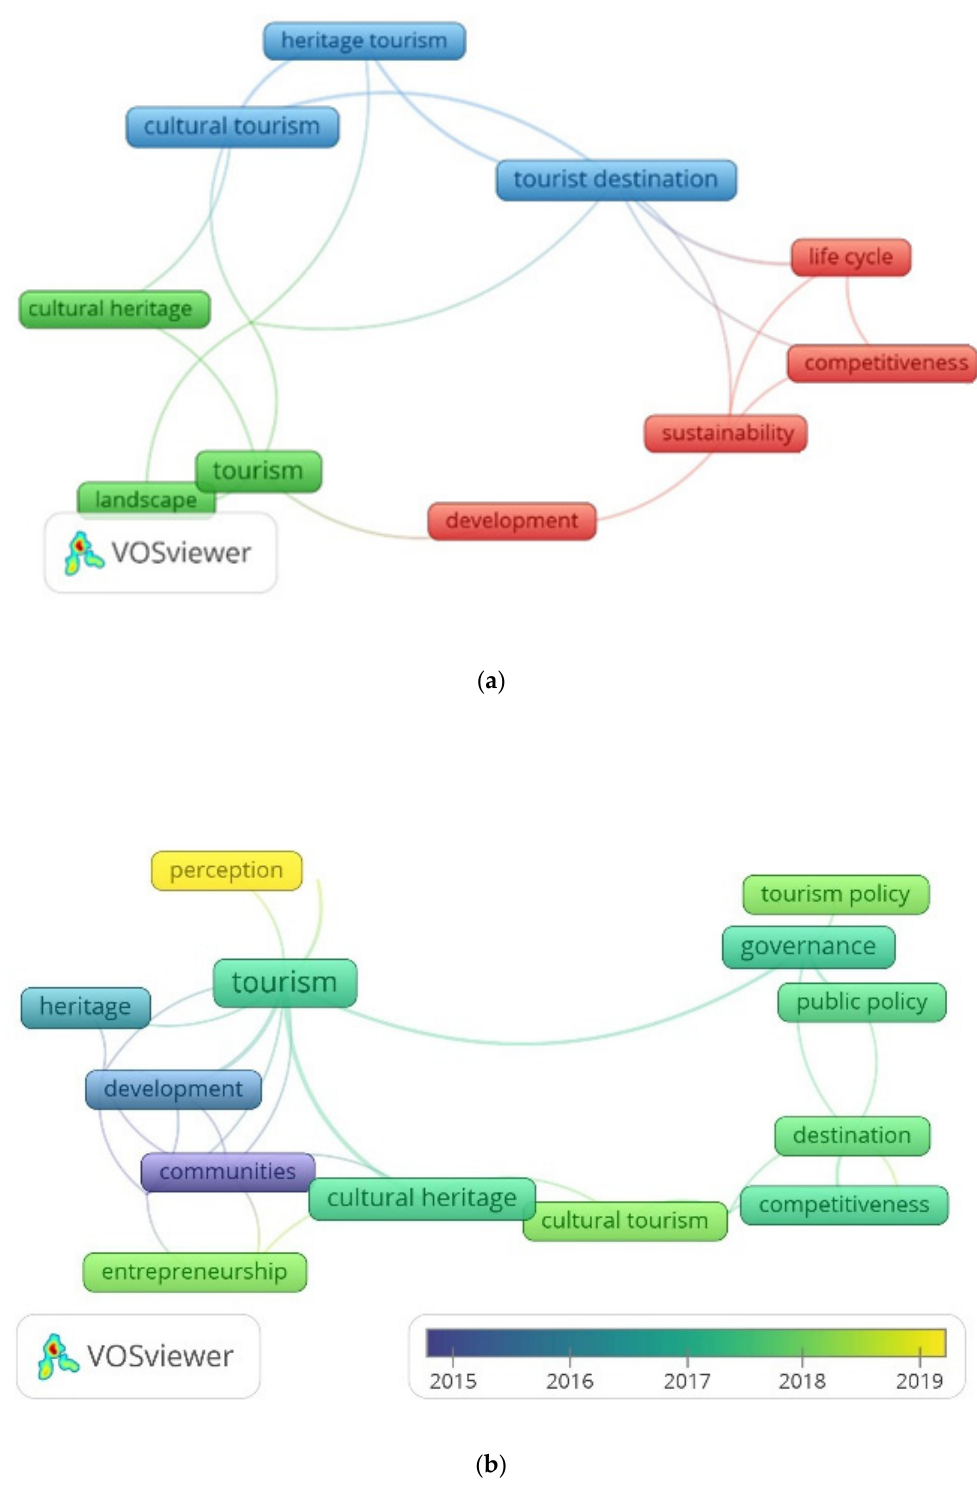
Figure 11. Network of co-occurrence of keywords in the 5 last years, ( a ) Scopus, ( b ) WoS. Source: Own elaboration.